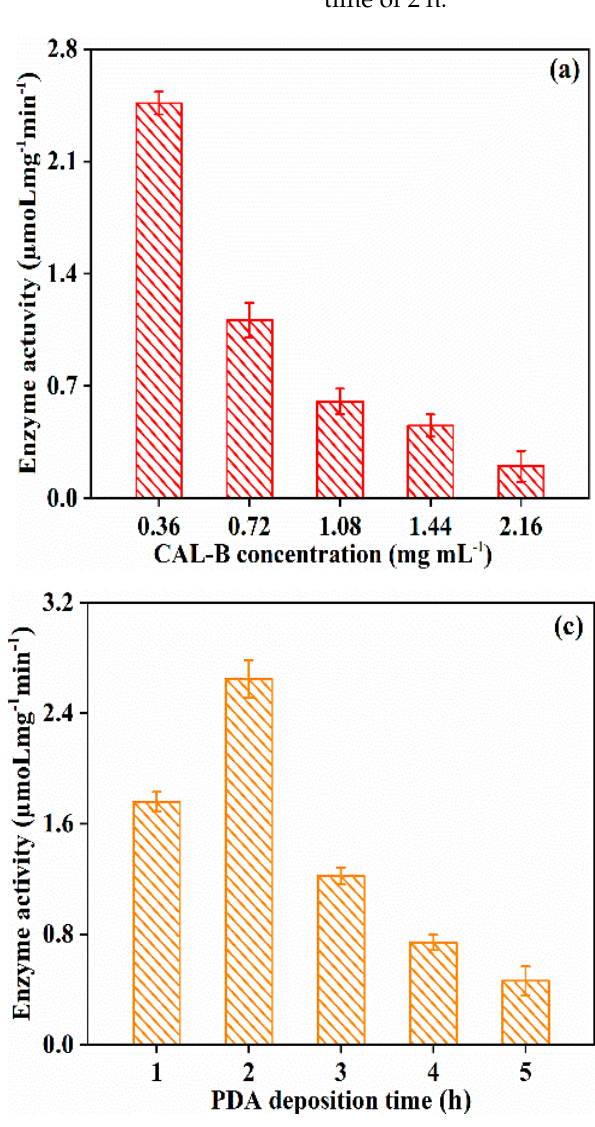
Figure 6. Enzyme activity of CAL-B@PDA/PES at different fabrication operating conditions: ( a ) CAL-B concentration, ( b ) operating pressure, and ( c ) PDA deposition time.